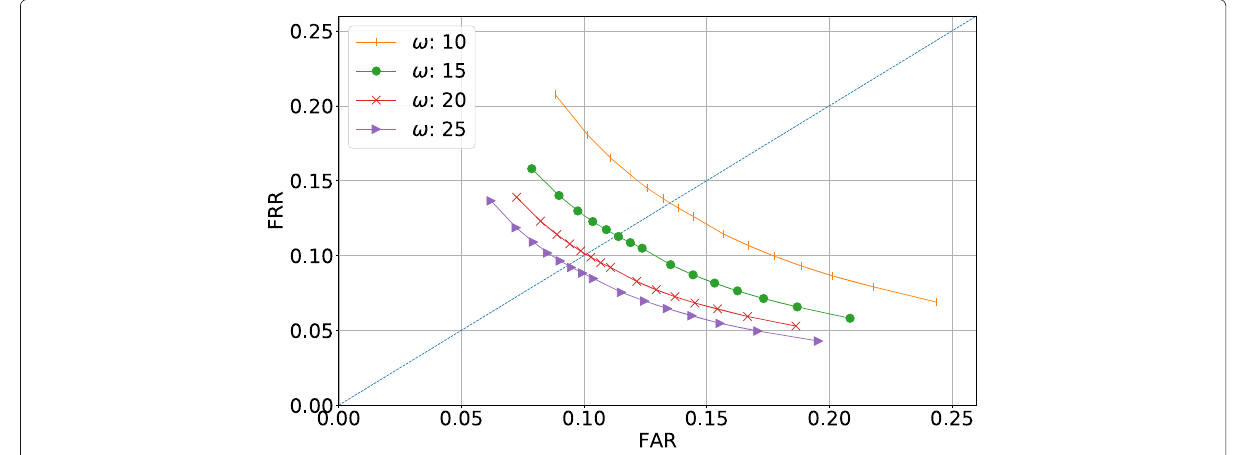
Fig. 3 DET curves for different values of the keystroke sequence length ω